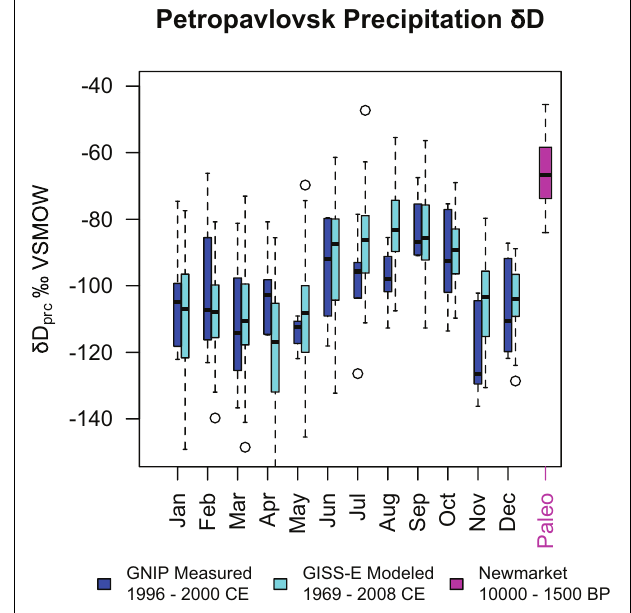
FIGURE 6 | Monthly hydrogen isotopes of precipitation measured at Petropavlovsk-Kamchatsky, modeled by GISS-E and compared with observations (Risi et al., 2012). All reconstructed hydrogen isotope values from Newmarket Fen are shown for comparison.